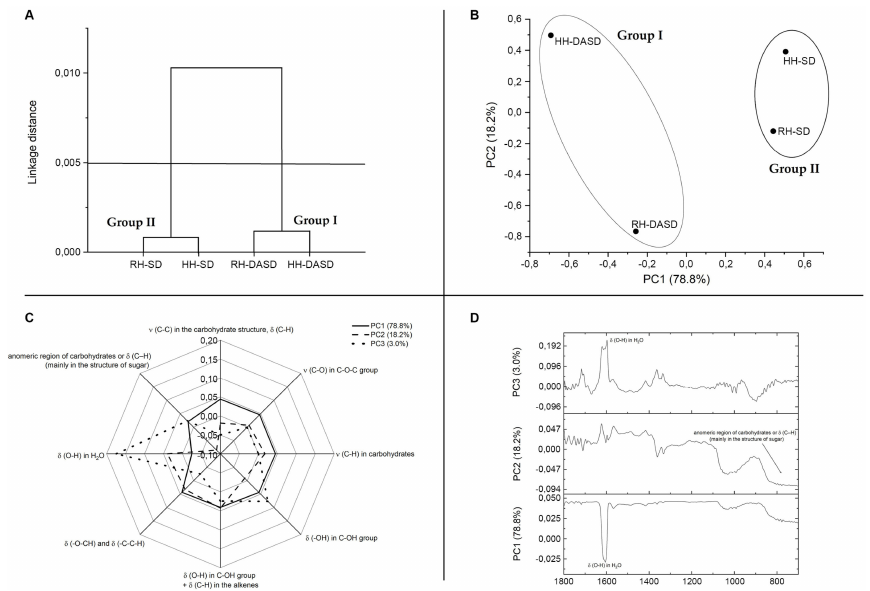
Figure 2. ( A )—Hierarchical cluster dendrogram constructed from the FTIR data for powders. ( B )—The scores plot of PCA (PC1xPC2) based on FTIR spectra of powders. ( C )—Spider web plot of the main type and origin of vibrations FTIR spectra in the terms of principal components PC1, PC2, PC3 for powders. ( D )—The loading factors of PCA. RH-SD, RH-DASD, HH-SD, HH-DASD